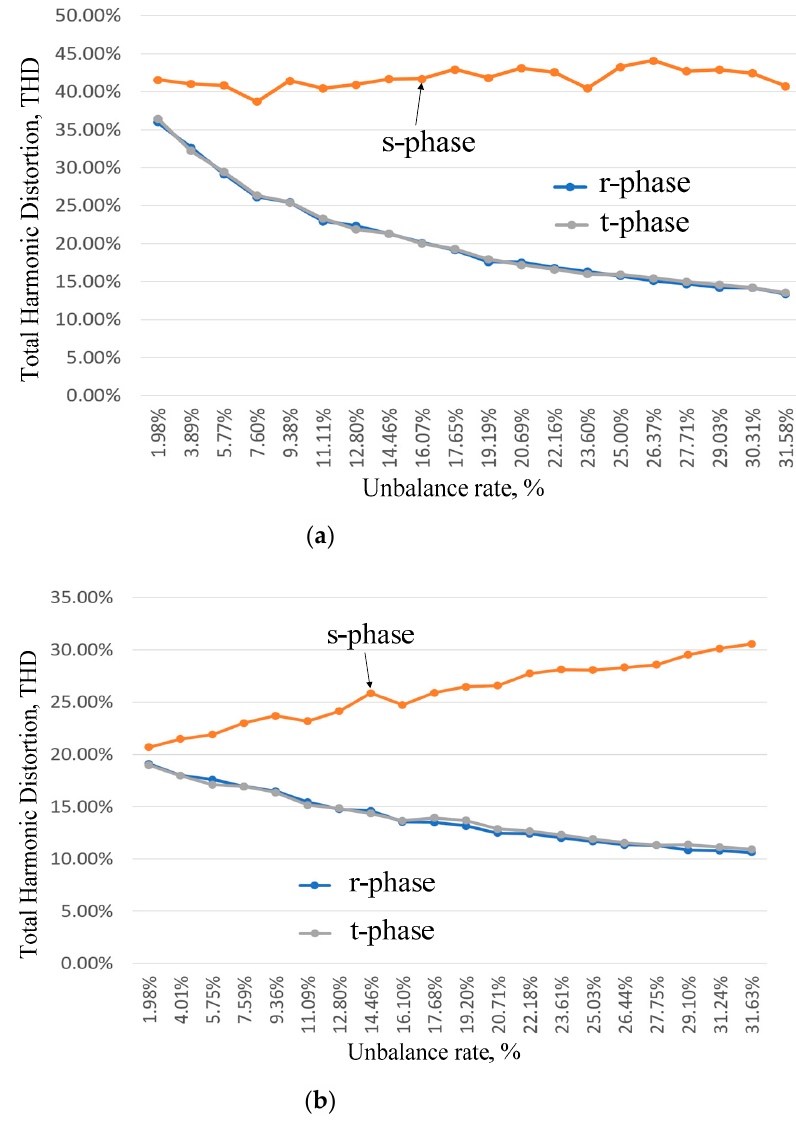
Figure 6. Comparison of THD of the phase current according to the increase in the unbalance rate in s-phase: ( a ) 3-leg inverter employing split dc-link capacitor; ( b ) 4-leg inverter.